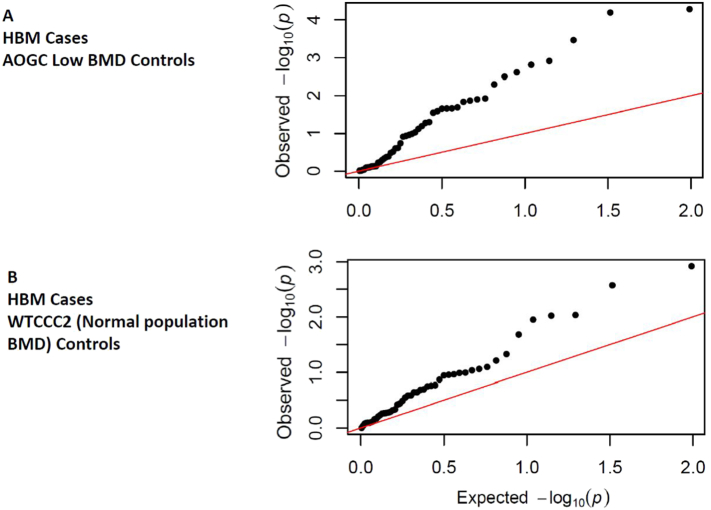
QQ plot for p values for 49 established BMD-associated loci in Case-Control GWAS of (A) unexplained HBM cases vs. AOGC low BMD controls, and (B) unexplained HBM cases vs. the second WTCCC2 (Wellcome Trust Case Control Consortium) controls. In both plots, the strength of observed associations for many SNPs far exceeded expected values.